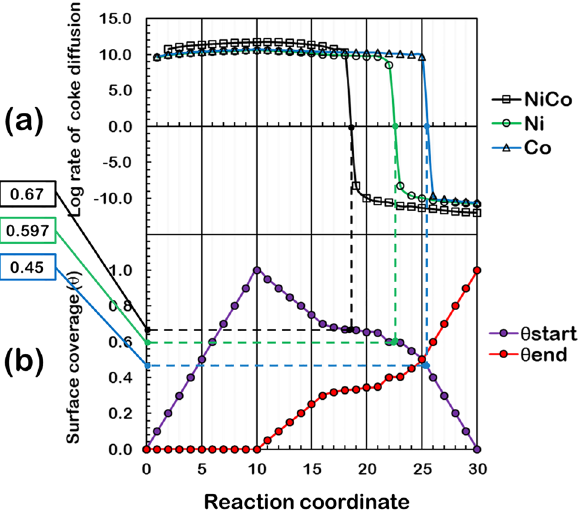
Figure 13. Coke mobility of Ni and NiCo catalysts represented by ( a ) the log rate of coke diffusion from the most stable C adsorption site to the nearby site for all catalysts and ( b ) the surface coverage of carbon atom of the initial and terminal diffusion site during 1st, 2nd, and 3rd stage of coke surface